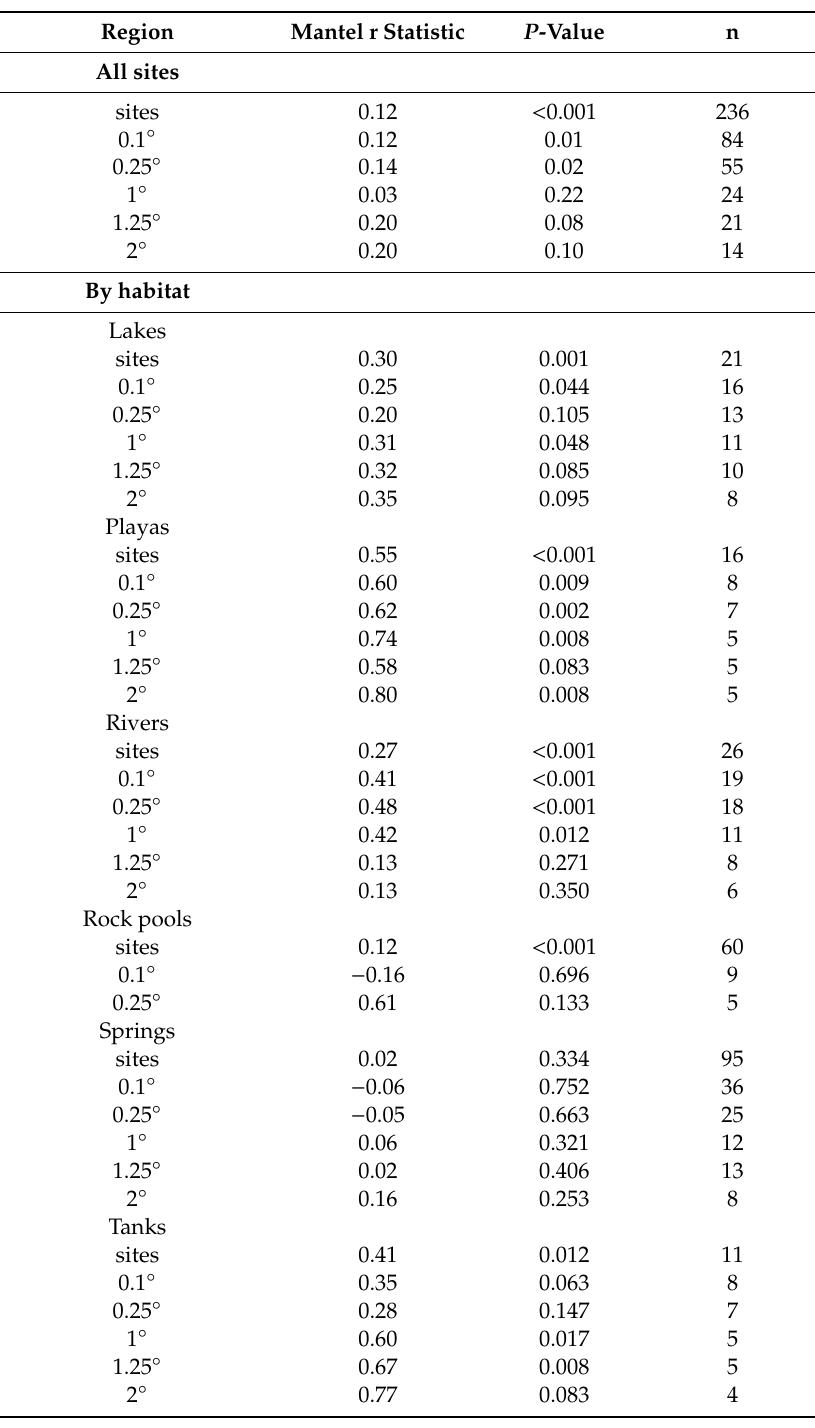
Table 4. Mantel correlation coe ffi cients (r) between Haversine geographic distances and Bray-Curtis dissimilarity values for rotifer communities between sites (n) at each grid size investigated. Habitat types were then analyzed separately, with the exception of streams due to low number of samples (n = 3 at grid size 0.1 ◦